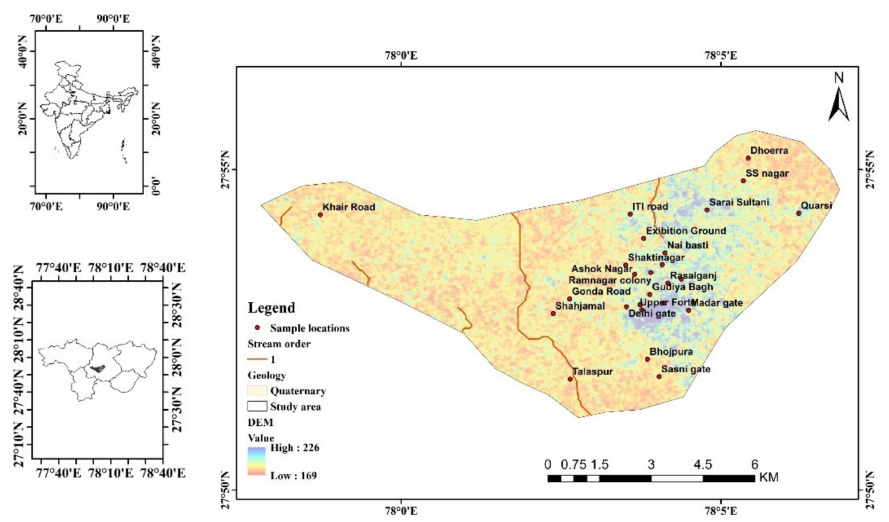
Figure 1. The map of the study area with sample locations in